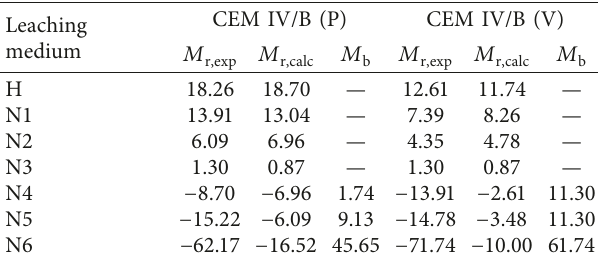
Table 7: Experimental and calculated M values. corresponding M b